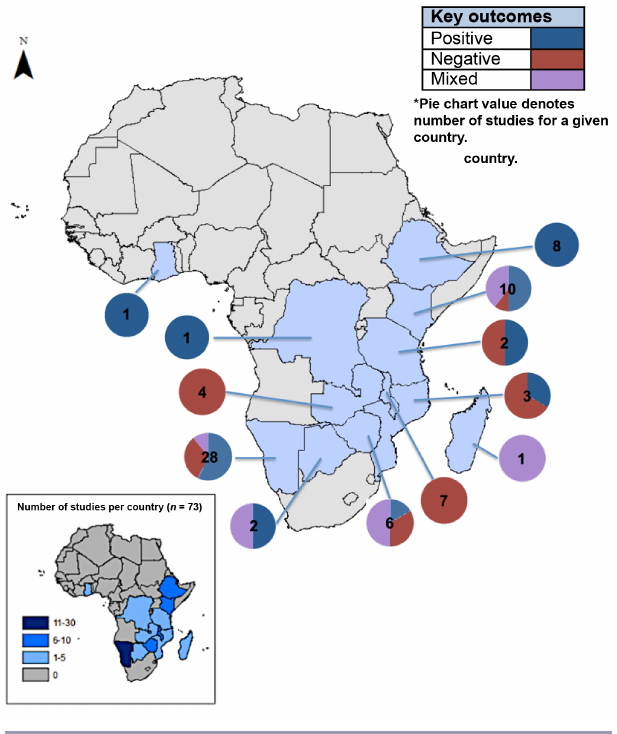
Fig. 4 . Key outcomes of community-based conservation (CBC): positive outcomes (48%; 35 cases), negative outcomes (36%; 26 cases), and mixed outcomes (16%;12